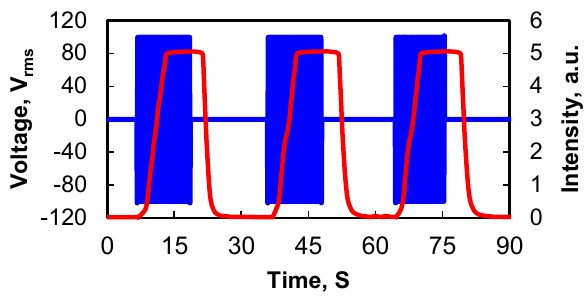
Figure 8. Light intensity change impacting with 100 V rms voltage